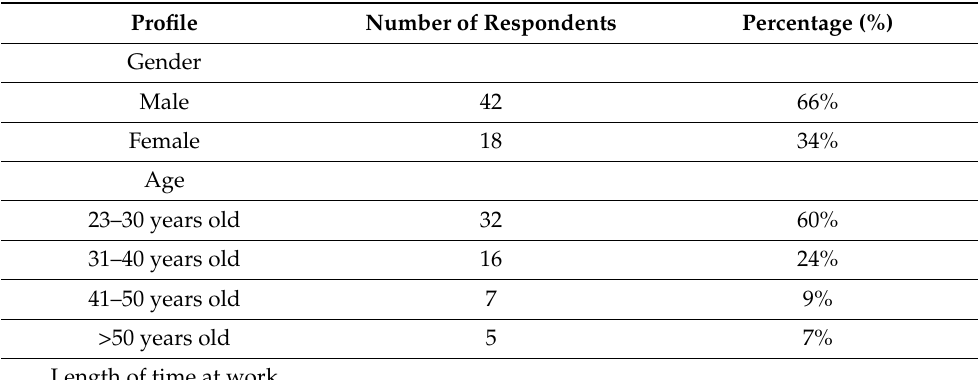
Table 2. Profile of